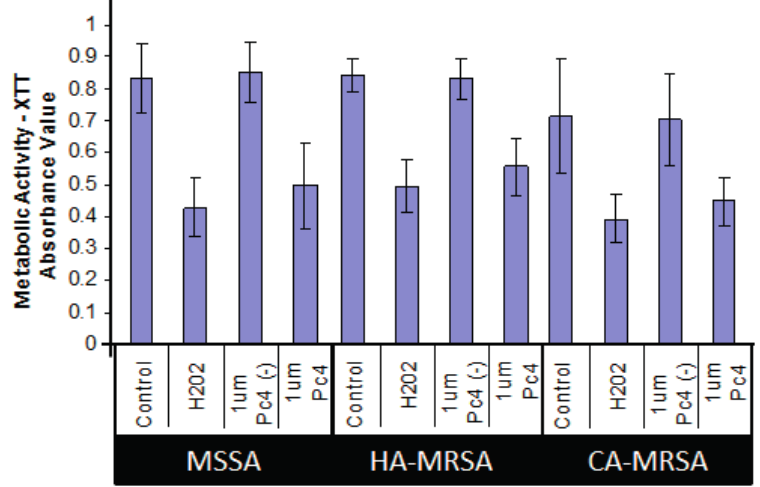
Figure 3. Cytotoxic effects, as measured by XTT, of Pc 4-PDT in MSSA, HA-MRSA and CA-MRSA. Equal quantities of three S. aureus culture strains were treated overnight with 1.0 μ M Pc 4 and then were irradiated with 2.0 J/cm 2 of 670–675 nm light. One hour following irradiation of Pc 4-loaded S. aureus , cultures were assayed for XTT reduction. H 2 O 2 was used for a positive control. Values represent mean ± S.E. from at least three independent experiments. For all Pc 4-PDT-treated cultures, p < 0.005 vs. light alone